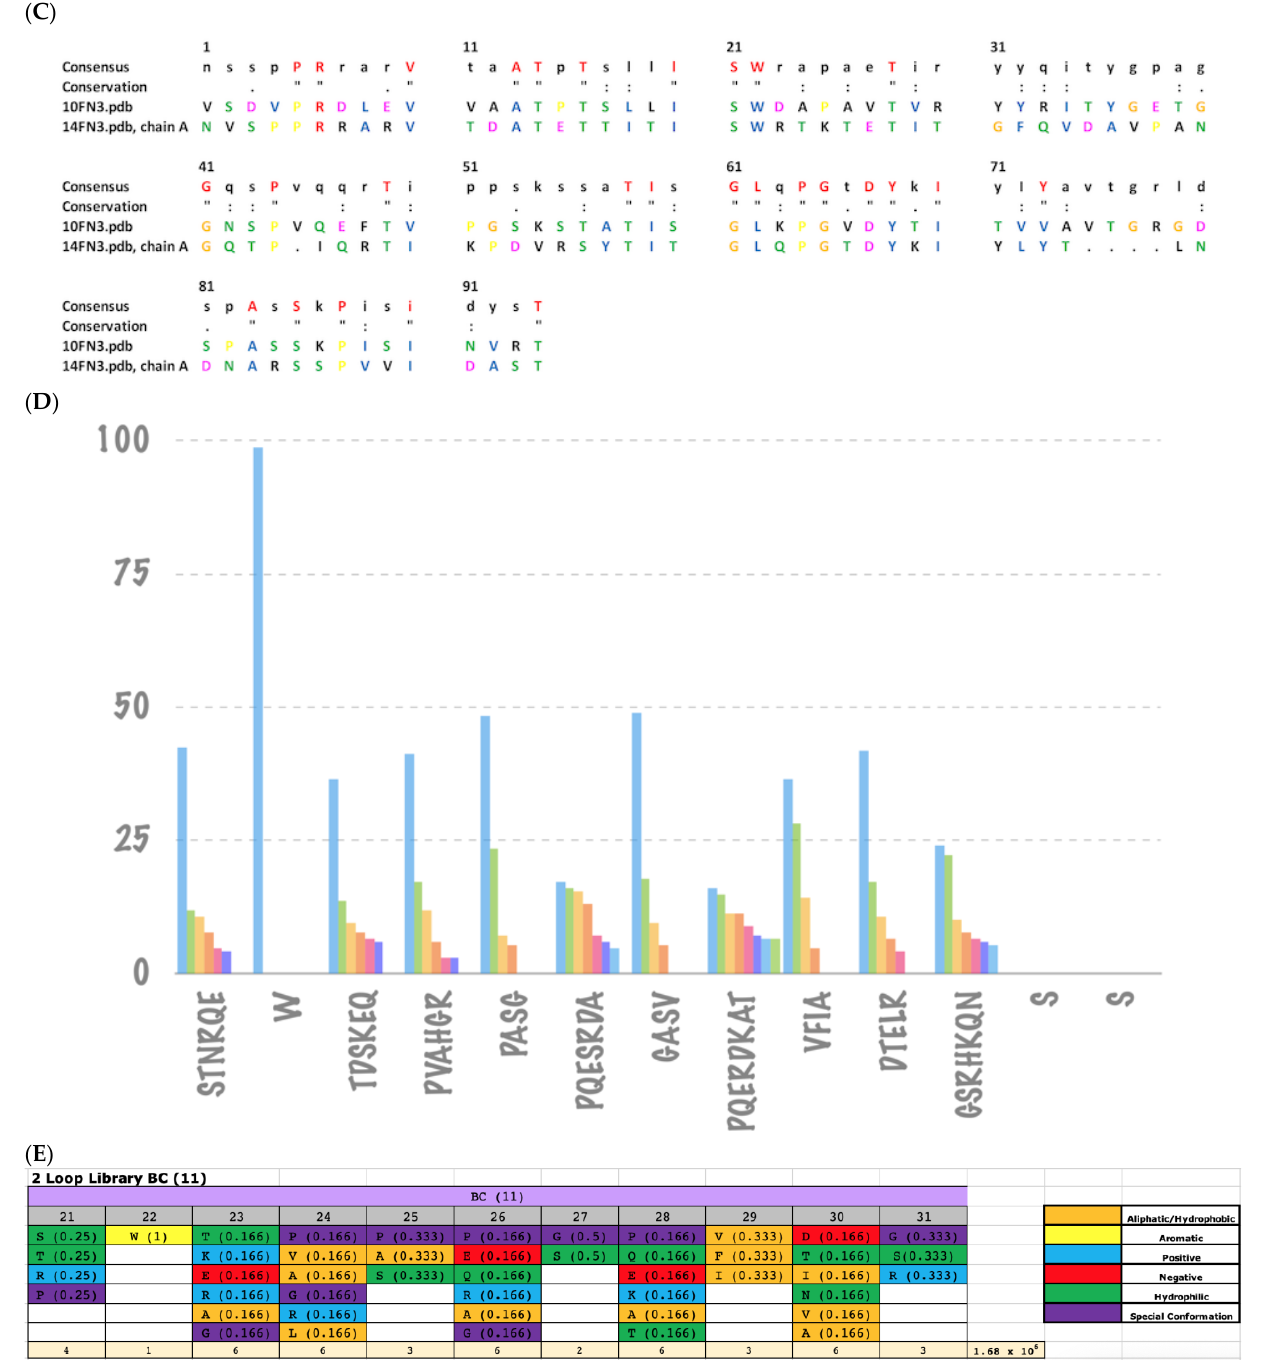
Figure 1. ( A ) Bioinformatic approach for 14FN3 selection as novel scaffold. ( B ) Identification of the most common loop sizes for FN3 domains. ( C ) Alignment of 10FN3 and 14FN3 sequences with * is conserved sequence, : is conservative mutation, and . is a semi-conservative mutation. ( D ) the amino acid distribution for BC loop (11) from human sequences. ( E ) The frequency of each amino acid for the BC (11) loop incorporated into the Pronectin Universal FN3 Library.